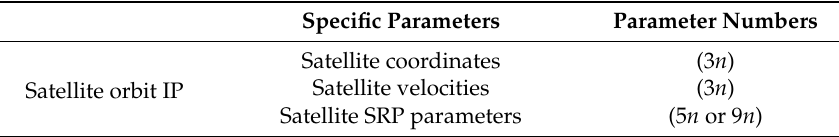
Table 1. Satellite orbit IP in the new real-time PPP system.